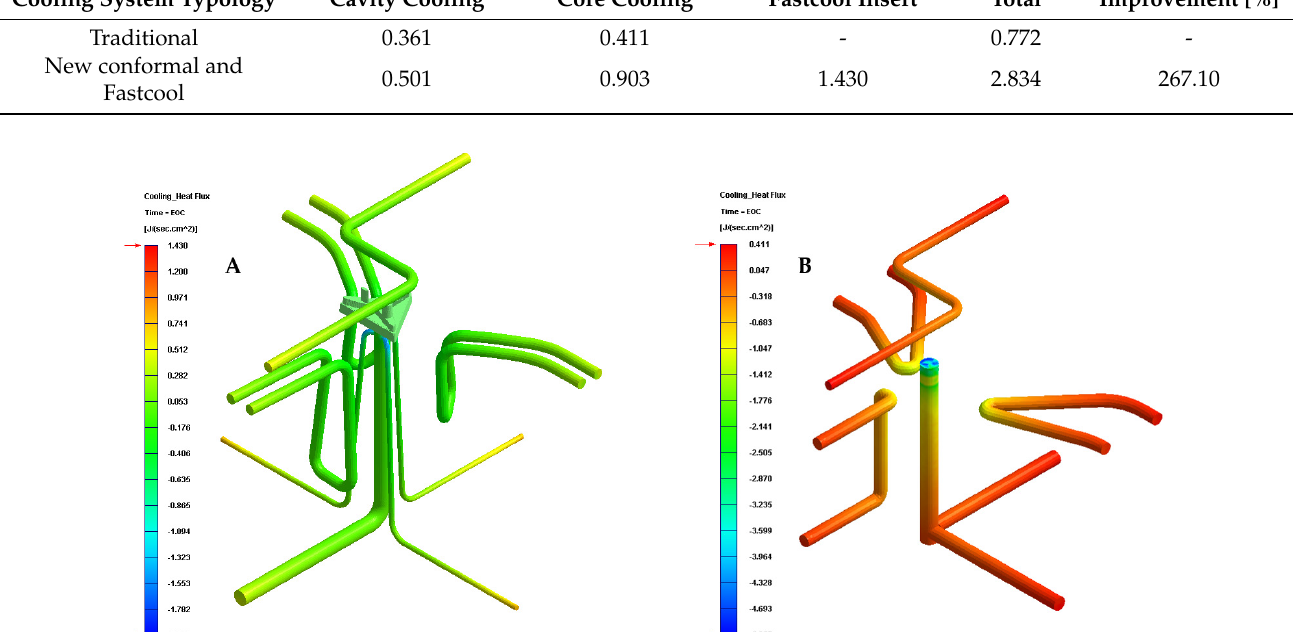
Table 9. Cooling mold temperature difference for the analyzed cooling